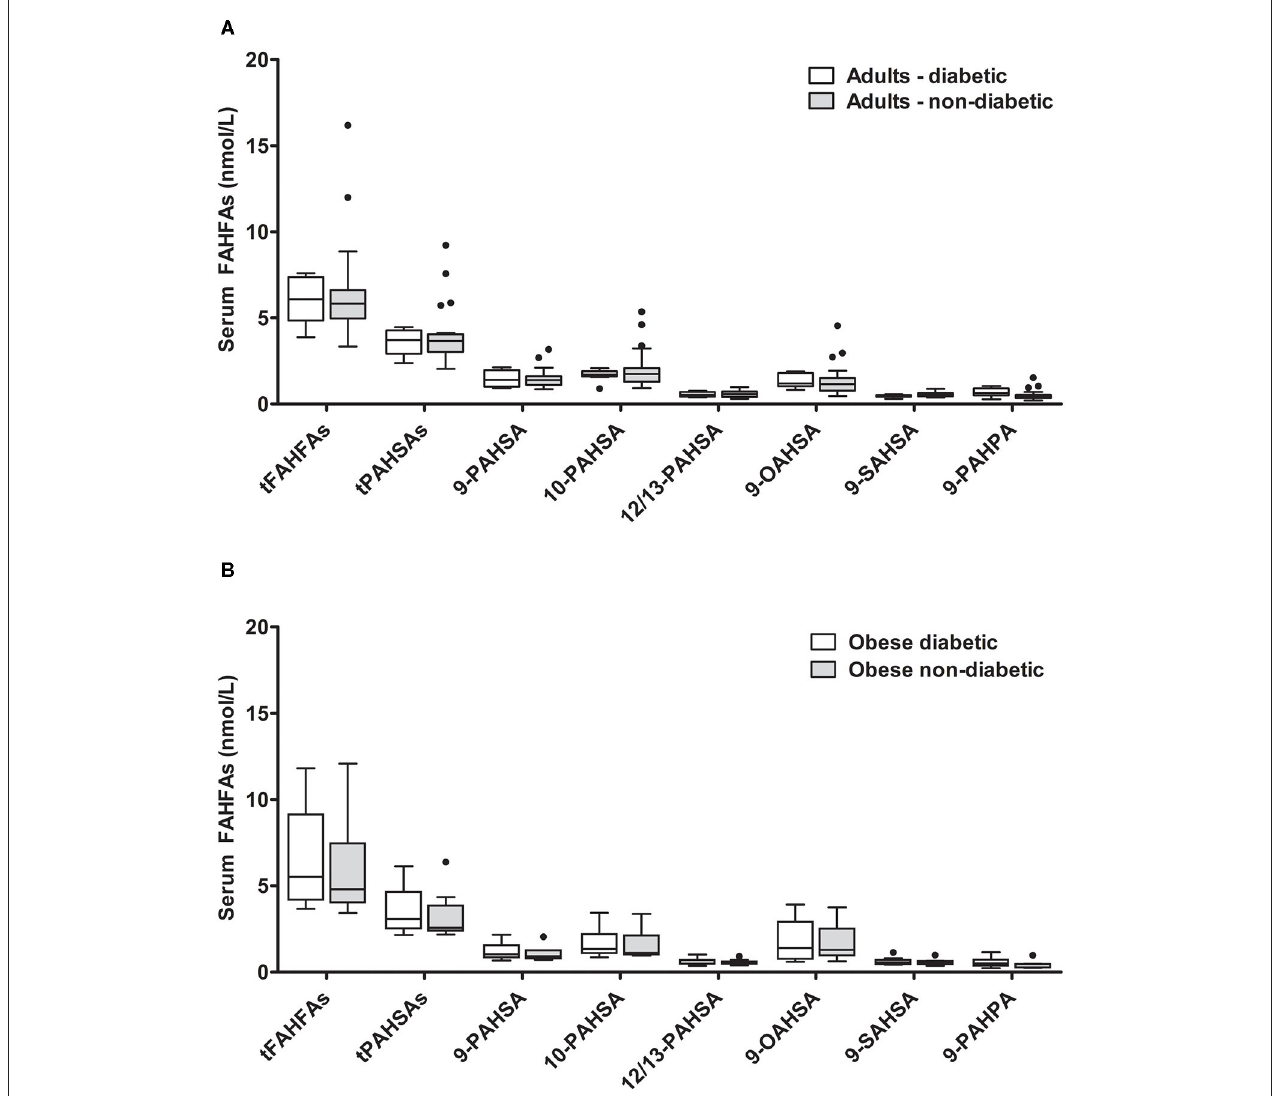
FIGURE 3 | FAHFA concentrations in diabetic and non-diabetic individuals. (A) FAHFA concentration was measured in diabetic and non-diabetic individuals from the enable cluster. Mann-Whitney test was used to compare the groups. n = 8/20 (diabetic/non-diabetic). (B) FAHFA concentration was measured in obese diabetic and obese non-diabetic individuals from the GOBB cohort. Mann-Whitney test was used to compare the groups. Box plots describe the median and the 25th percentile and 75th percentile. n = 10 per group. t, total (sum of FAHFAs/PAHSAs measured); FAHFA, fatty acid ester of hydroxy fatty acid; OAHSA, oleic acid-hydroxy stearic acid; PAHPA, palmitic acid-hydroxy palmitic acid; PAHSA, palmitic acid-hydroxy stearic acid; SAHSA, stearic acid-hydroxy stearic acid.